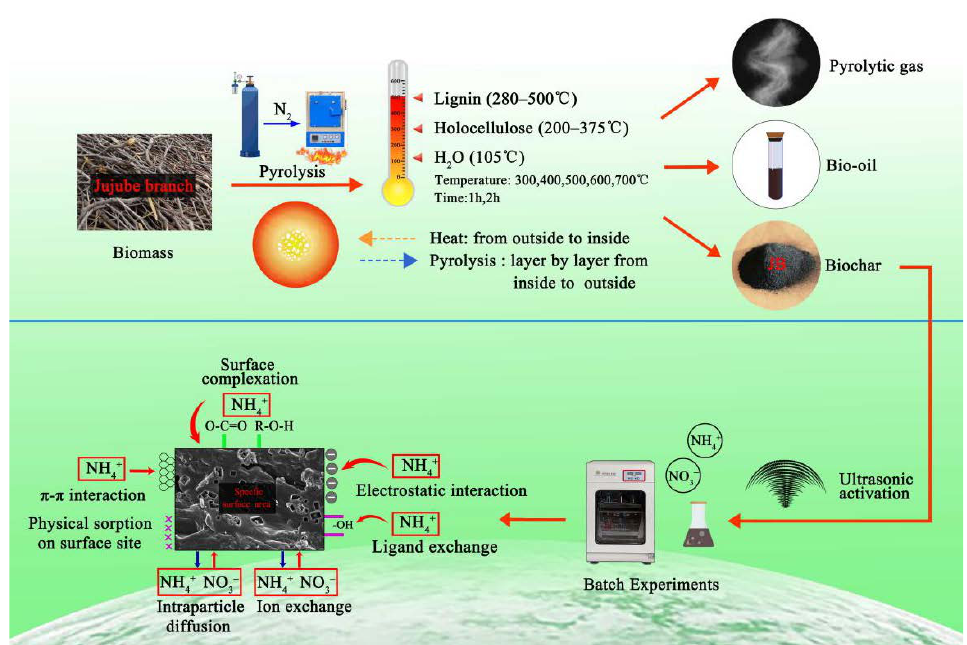
Figure 12. FTIR spectrograms of JB and after the absorption of NO 3 − and NH 4+ .